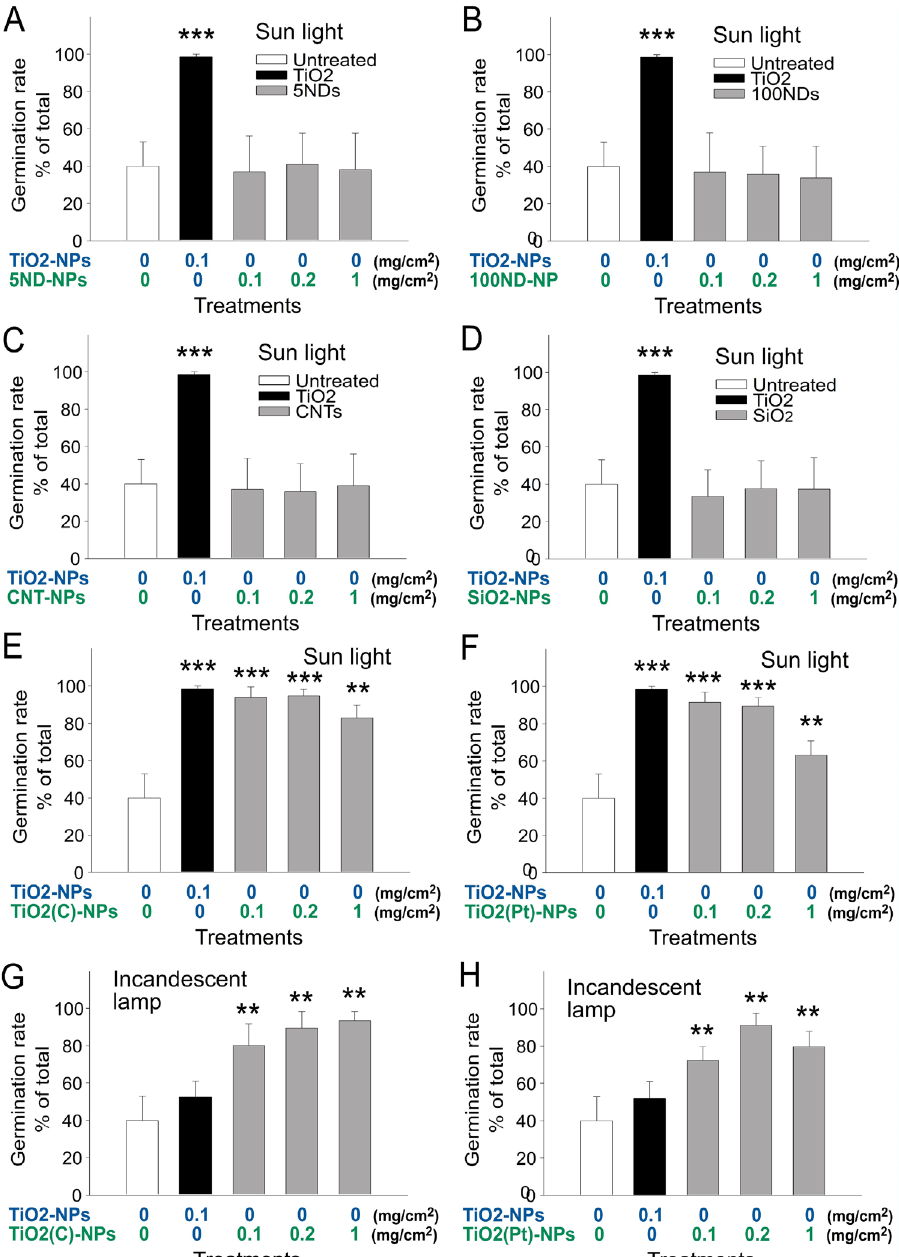
Figure 6. Photocatalysis is essential for TiO 2 NP-mediated enhancement of seed germination. The germination rates of Amaranthus mangostanus seeds grown on soil with supplements of 5 nm nanodiamond (ND) ( A ), 100 nm ND ( B ), carbon nanoparticle (NP) ( C ), SiO 2 NP ( D ), visible light-responsive photocatalysts TiO 2 ( C,E,G ) and TiO 2 (Pt) ( F,H ) under daily sunlight ( A–F ) or visible light ( G,H ) illumination were compared with pure TiO 2 (UV-responsive photocatalyst) and then quantified. ** P < 0.01, *** P < 0.001 vs. 0 mg/cm 2 TiO 2 untreated groups. n = 3 (3 independent experiments; each experiment with 30